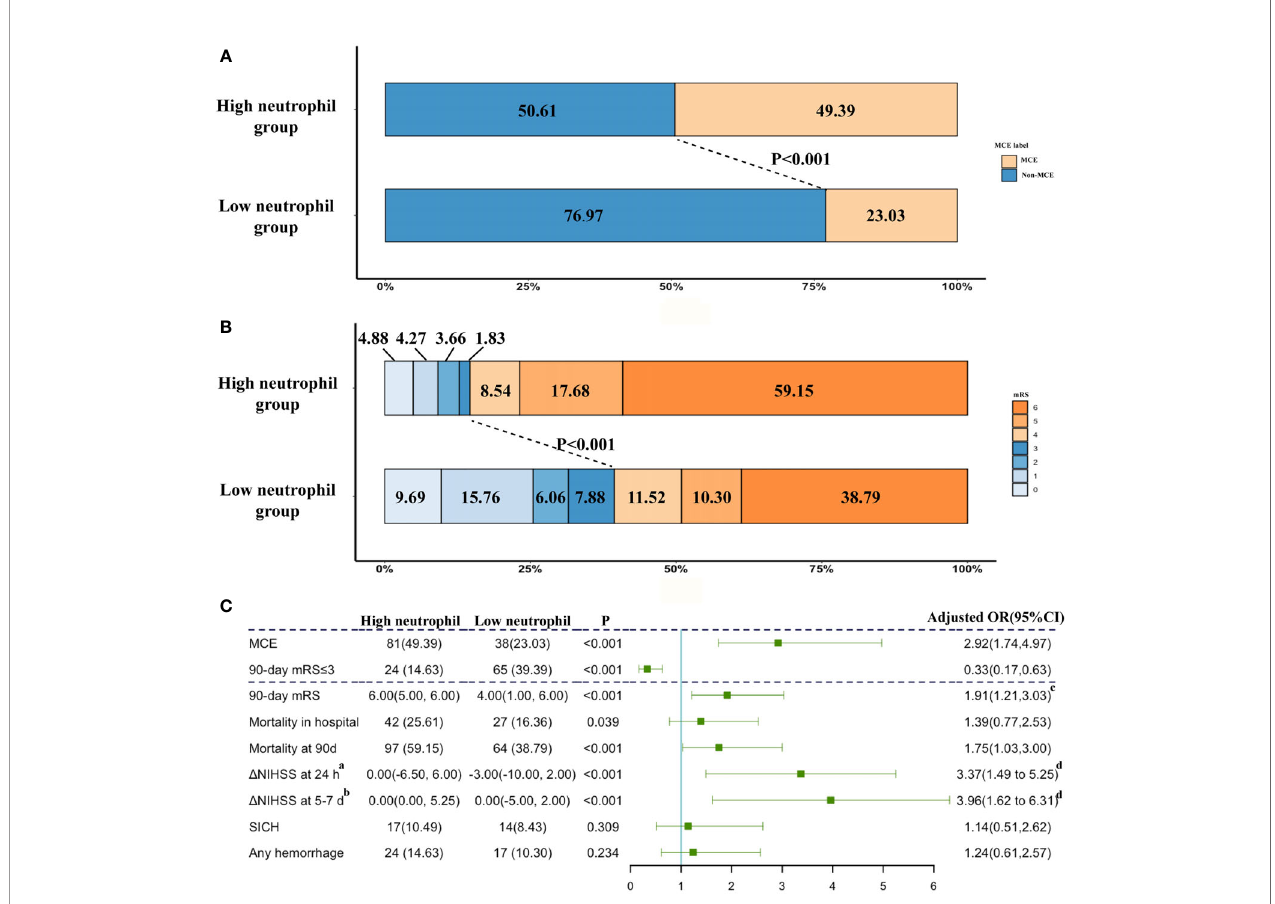
FIGURE 2 | The impacts of neutrophil count on clinical outcome. (A) Distribution of the MCE across patients with different neutrophil count status; (B) Distribution of the mRS scores at 90 days according to the trichotomized neutrophil count status. (C) Adjusted logistic regression models evaluated the associations between neutrophil level with outcomes. a Change from NIHSS at admission from NIHSS at 24 h after EVT. b Change from NIHSS at admission from NIHSS at 5-7 days after EVT. c Adjusted common OR; adjusted estimates of outcome were calculated using multiple regression, taking the following variables into account: baseline NIHSS score, baseline PC-ASPECTS, neutrophil count, mTICI, PC-CS score, occlusion sites, and onset to recanalization time. d ß-values were estimated from a multivariable linear regression model; adjusted estimates of outcome were calculated using multiple regression, taking the following variables into account: baseline NIHSS score, baseline PC-ASPECTS, neutrophil count, mTICI, PC-CS score, occlusion sites, and onset to recanalization time. NIHSS, National Institutes of Health Stroke Scale; mRS, modi fi ed Rankin Scale score at 90